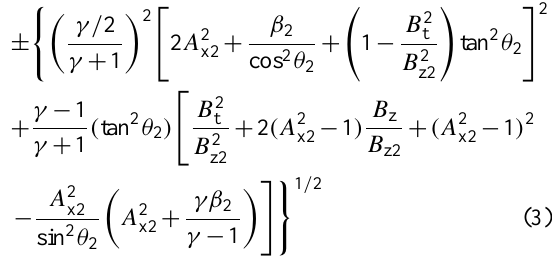
22 =1.0063 and ! = 1.134 chosen 1166 x